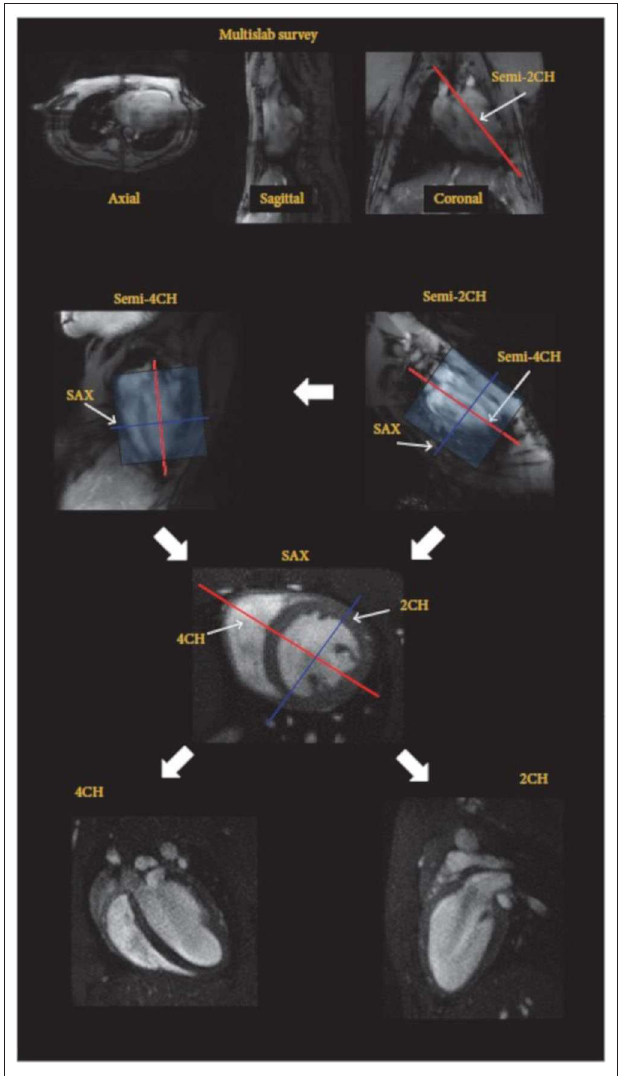
FIGURE 3 | Imaging protocol for highly reproducible imaging of cardiac function and anatomy (2/4CH: 2/4-chamber, SAX: short axes orientations). After the acquisition of a fast survey in axial, sagittal, and coronal orientation a long axis (LAX) scans are acquired in semi-2 chamber (2CH) and semi-4 chamber (4CH) orientation, which are used for accurate planning of the short axis stack (SAX). The final 2CH and 4CH orientations are planned on the SAX stack. Reproduced with permission from Zuo et al.